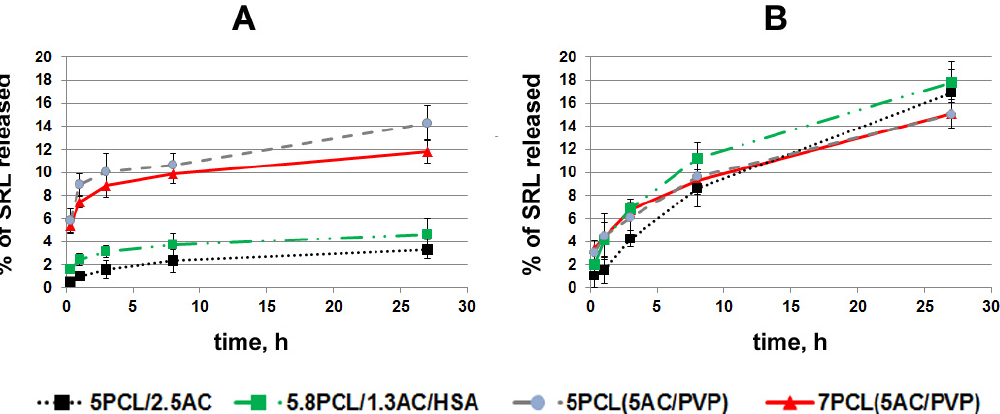
Figure 6. Kinetic curves of SRL release in PBS ( A ) and in BP ( B ). For adsorption of SRL, discs were incubated with SRL 10 µg/mL for 48 h in PBS or in BP. Then, supernatant was removed, and fresh PBS or BP was added. Scaffolds were incubated in PBS ( A ) or BP ( B ) for 30 min, 60 min, 3 h, 9 h and 27 h.